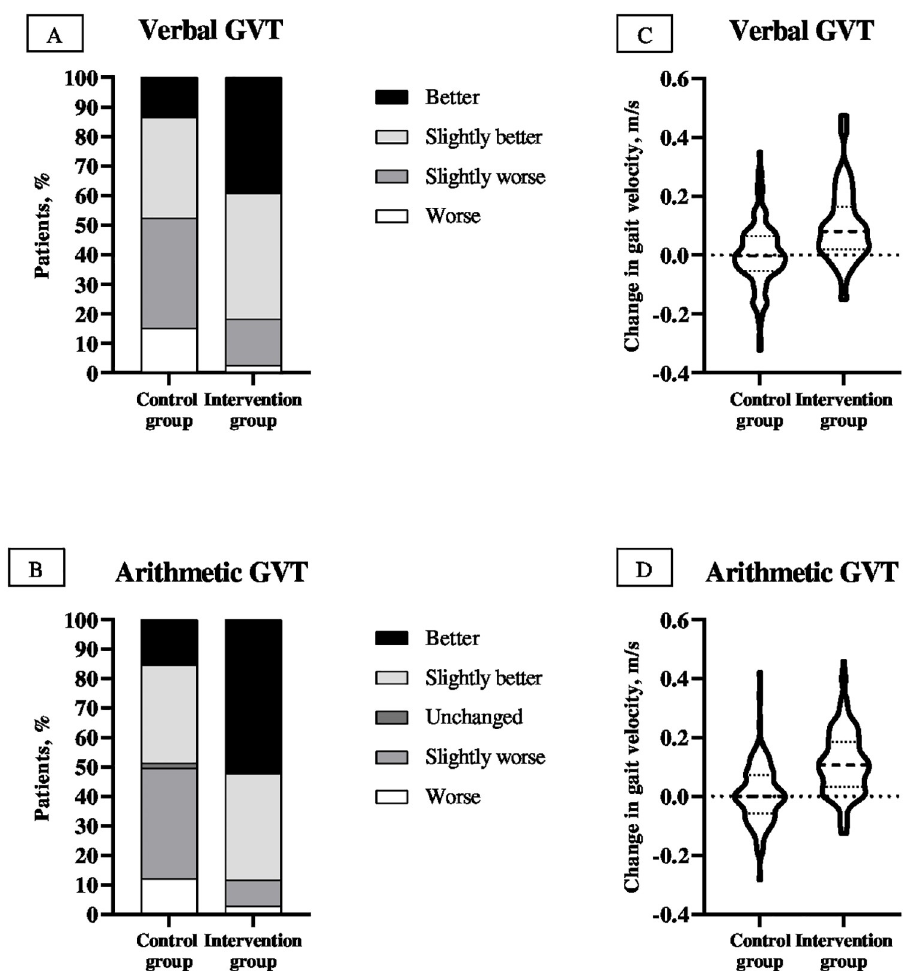
Fig 2. Changes from baseline to discharge (A and B) and within-group punctuation change distribution (C and D). Dual-task GVT changes: “better” indicates an improvement of more than 0.1 m/s, “slightly better” indicates an improvement between 0.001 and 0.1 m/s, “unchanged” indicates no difference, “slightly worse” indicates a decline between 0.001 and 0.1 m/s, and “worse” indicates a decline of more than 0.1 m/s. The proportion of patients showing overall improvement and worsening in the dual-task GVTs was significantly higher and lower, respectively, in the intervention than in the control group (all p < 0.001 with χ 2 test). In the violin plots, the horizontal dotted lines indicate Q1 and Q3, and the horizontal dashed line within the violin, the median. GVT, Gait Velocity Test; Q1, First Quartile; Q3, Third Quartile.